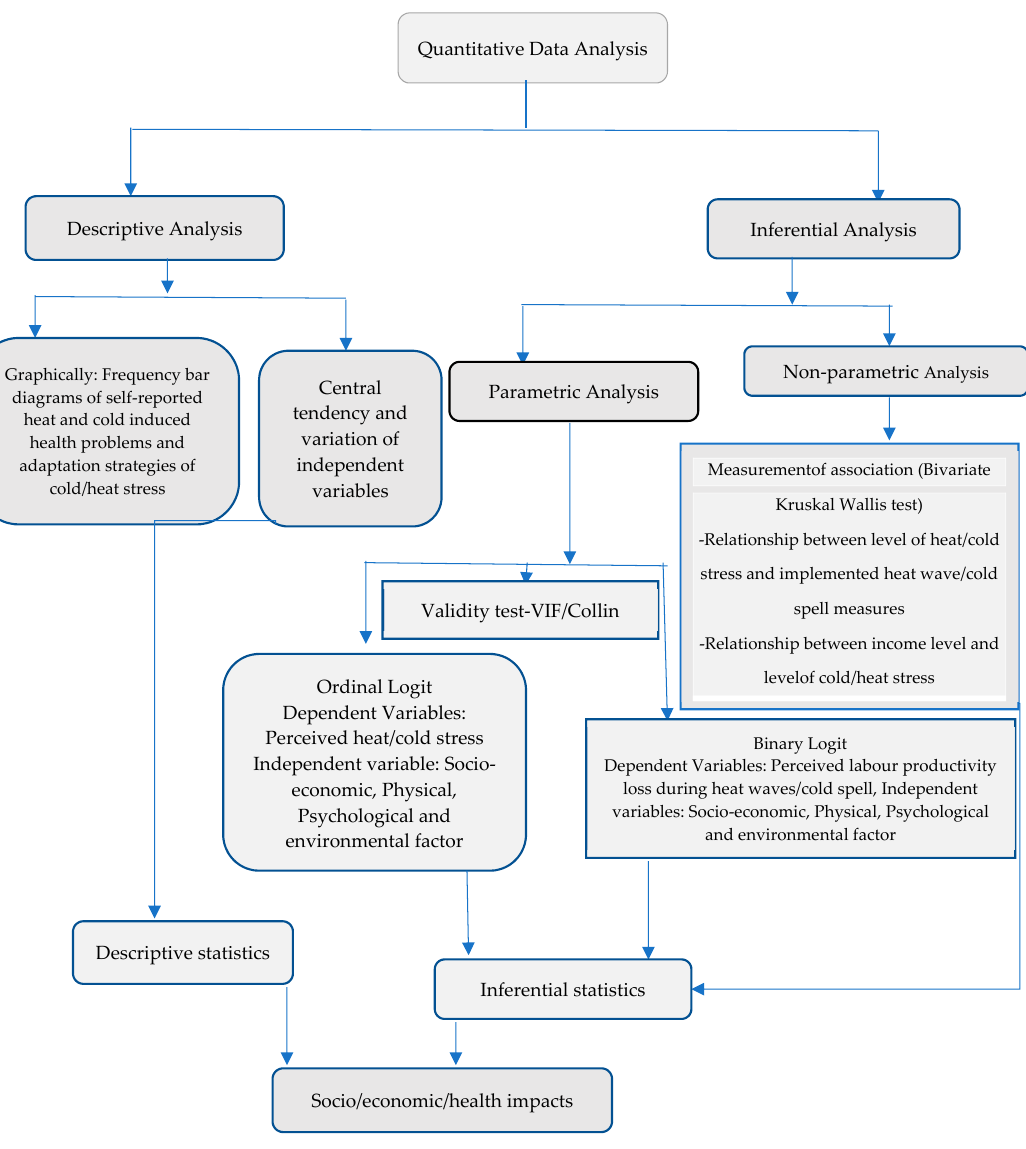
Figure 2. Analytical framework.